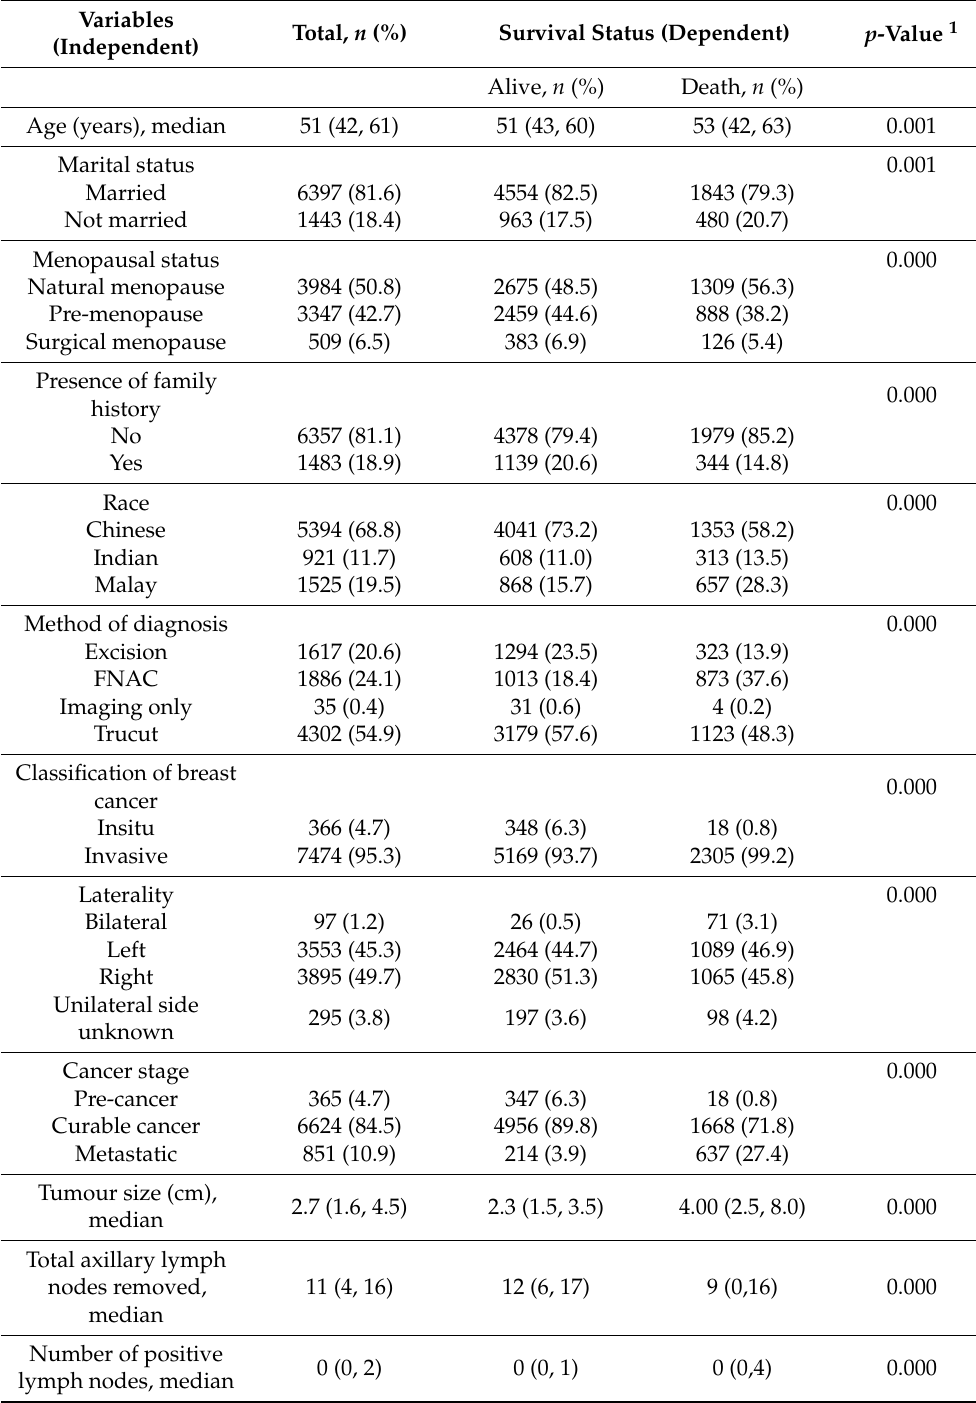
Table 4. Results from significant factor analysis in